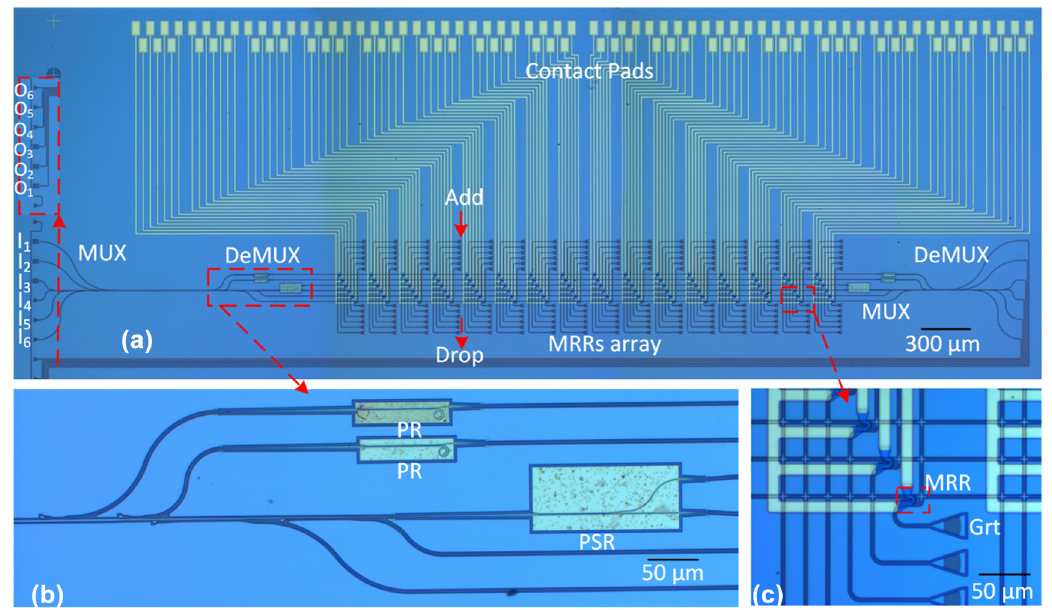
Figure 9: Microscopy images of the fabricated ROADM for hybrid WDM-MDM-PDM systems (a), the enlarged mode/polarization DEMUX (b), and the enlarged view for the MRR-based wavelength-selective optical switches (c).